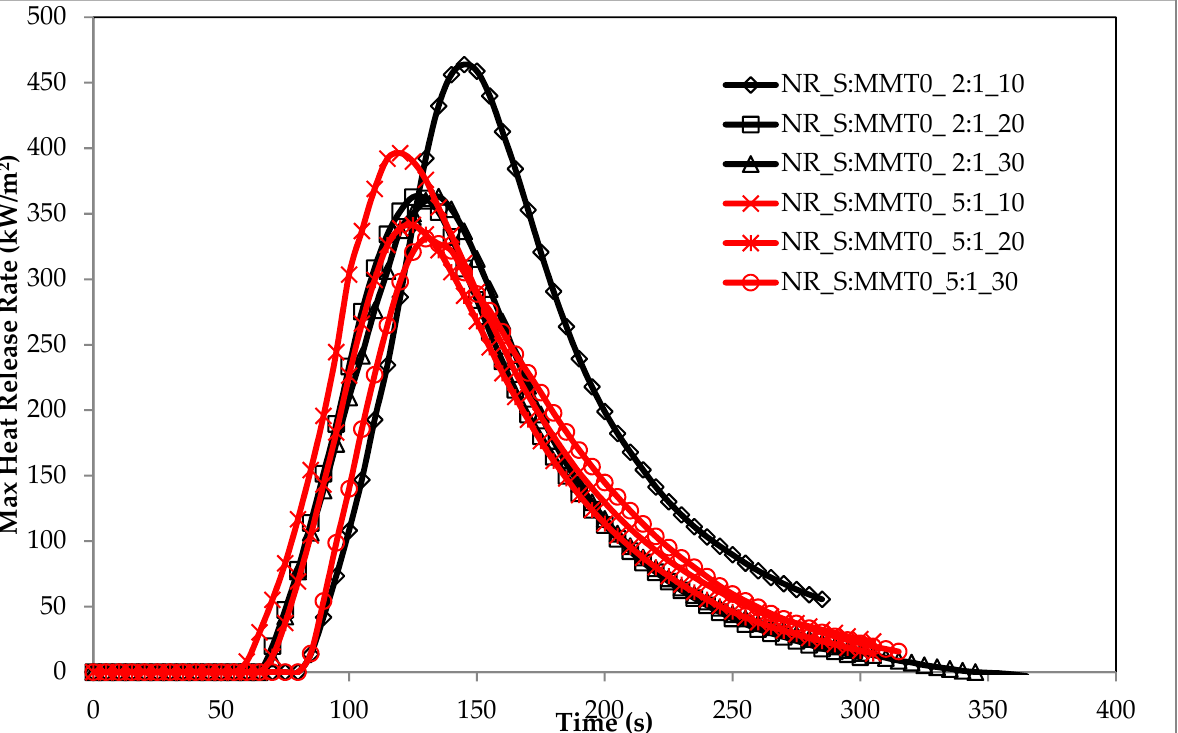
Figure 17. The HRRmax parameter of biocomposites filled with S:MMT0.